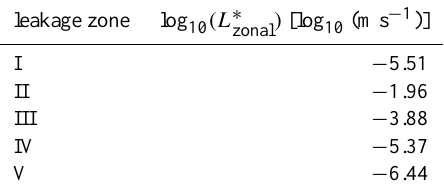
Table 2. Predefined zonal leakage values for generation of reference fields for scenario C. Leakage zones are numbered from west to